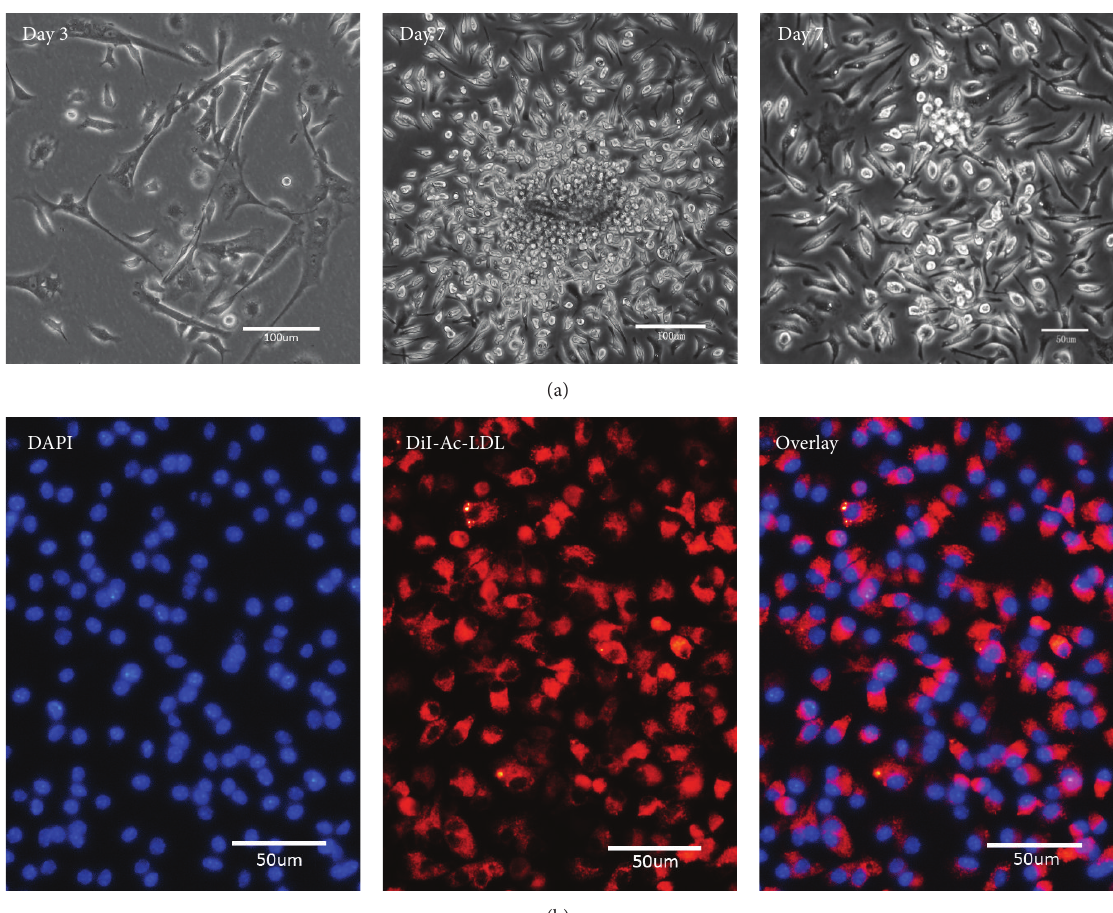
Figure 1:Characterization of EPCs.(a)Mononuclear cells were adhered and showed a spindlemorphology in 72 hours. After 7 days, cells with oval and spindle shape formed cell colonies. (b) The spindle-shaped adherent cells that were positive for Dil-Ac-LDL uptake were identified as EPCs.